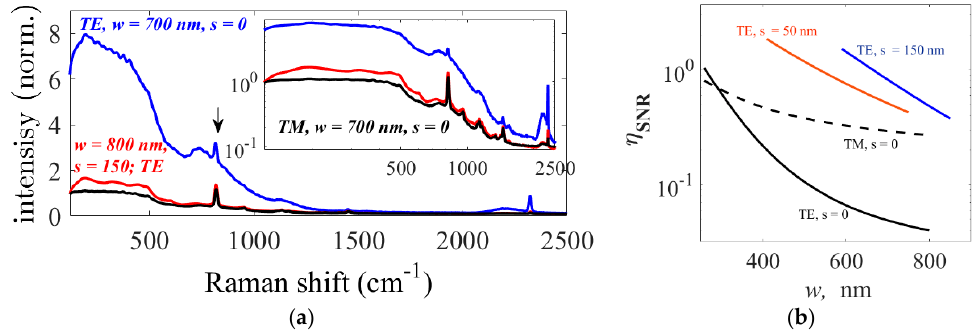
Figure 5. ( a ) The raw spectra of IPA measured using NWERS containing peaks from IPA as well as WGBL for w = 700 nm strip waveguide for TE (blue line) and TM (black line) polarization. The red spectrum for slotted waveguide, with s = 150, w = 800, and measured using the fundamental TE mode, is also shown. The spectra are normalized to the height of the IPA peak at 819 cm − 1 (marked with an arrow) for comparison of their relative strengths; ( b ) Calculated value for signal-to-noise ratio (SNR)-equivalent efficiency for different waveguide geometries as a function of waveguide width.